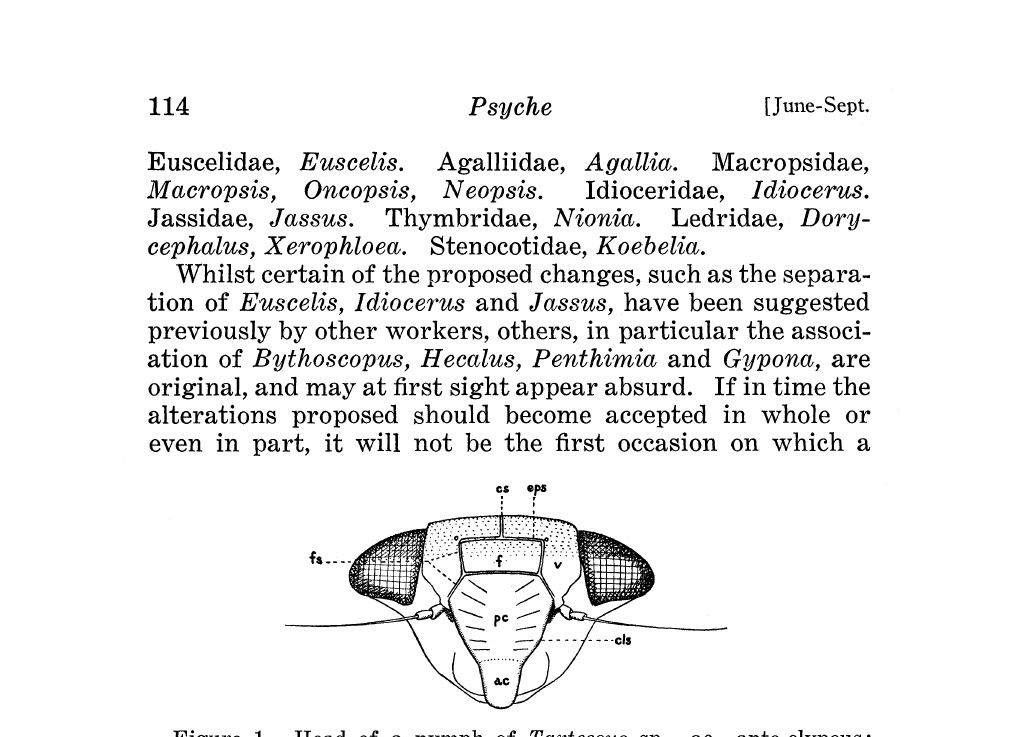
Figure 1. Head of a nymph of Tartessus sp. ac., ante-clypeus; pc., post-clypeus; f., frons; cls., clypeal sutur.e; fs., frontal suture; v., verte:x; cs., coronal suture; eps., epicranial